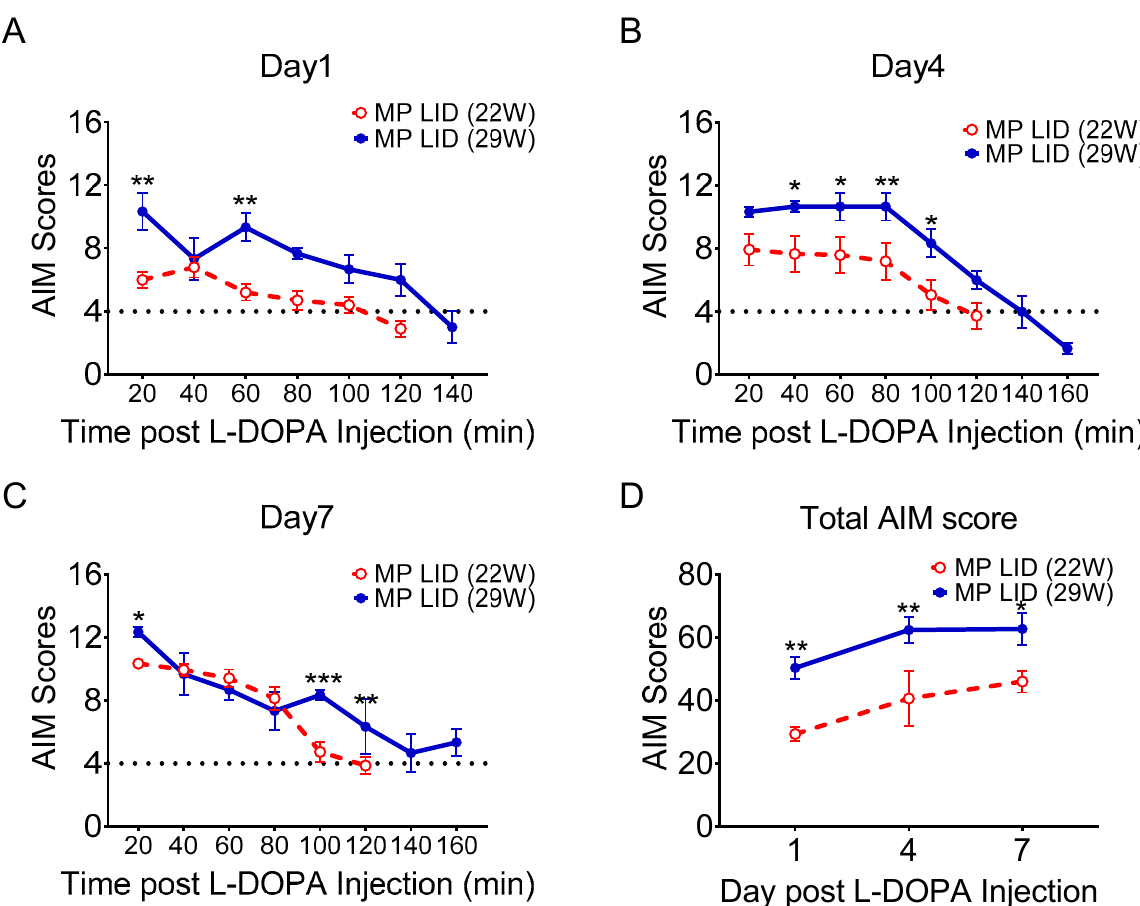
Figure 1. Effect of L-DOPA treatment on MitoPark (MP) of different ages. Comparison of AIM scores between mice that received early PT320 treatment (treatment begun at 5 weeks old and AIM recorded at 22 weeks old) and late treatment (treatment begun at 17 weeks old and AIM recorded at 29 weeks old). AIM scores at ( A ) 1, ( B ) 4, and ( C ) 7 days of L-DOPA/carbidopa treatment in 22-week- and 29-week-old MP mice as well as overall AIM scores ( D ). ( A ) AIM scores in the late treatment group were higher than those in the early group at almost all time points. ( B ) AIM scores were higher in the late treatment group at the middle and late recording time points on day 4. ( C ) Abnormal dyskinesias were longer in the late treatment group. ( D ) Total AIM scores were higher in the late treatment group from day 1 to day 7 after induction protocol. Two-way analysis of variance (ANOVA) followed by Bonferroni post hoc test for multiple comparisons. * p < 0.05, ** p < 0.01, *** p < 0.001 compared with MP LID